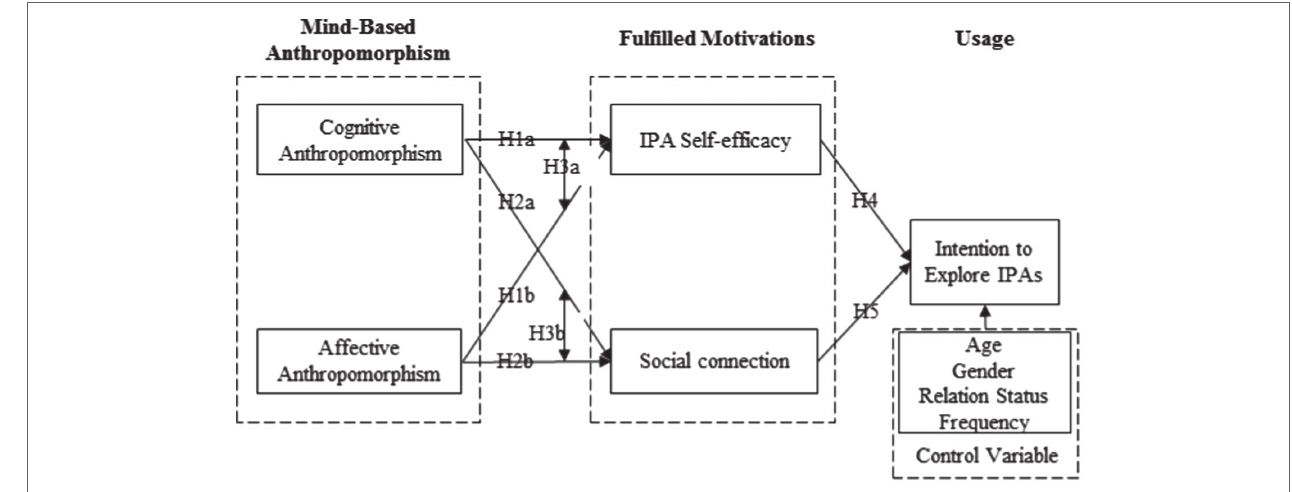
FIGURE 1 | Research